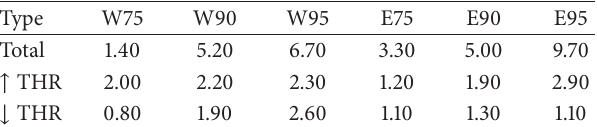
Table 6: Scaling slopes. W/E denotes western/eastern region. Numbers (75, 90, and 95) denote the respective